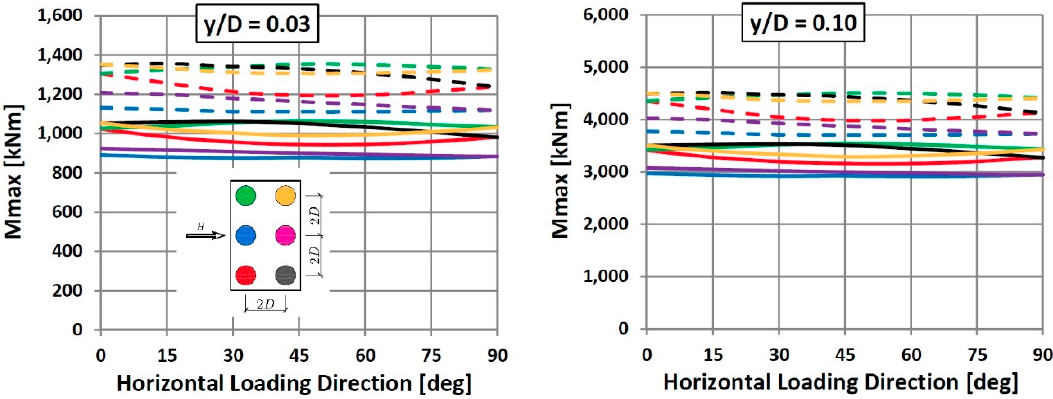
Figure 15. Maximum bending moments for rectangular 2 × 3 pile group ( s x = 2 D , s y = 2 D ). Different colors denote piles inside the pile group. Full lines—loose sand; dashed lines—dense sand.